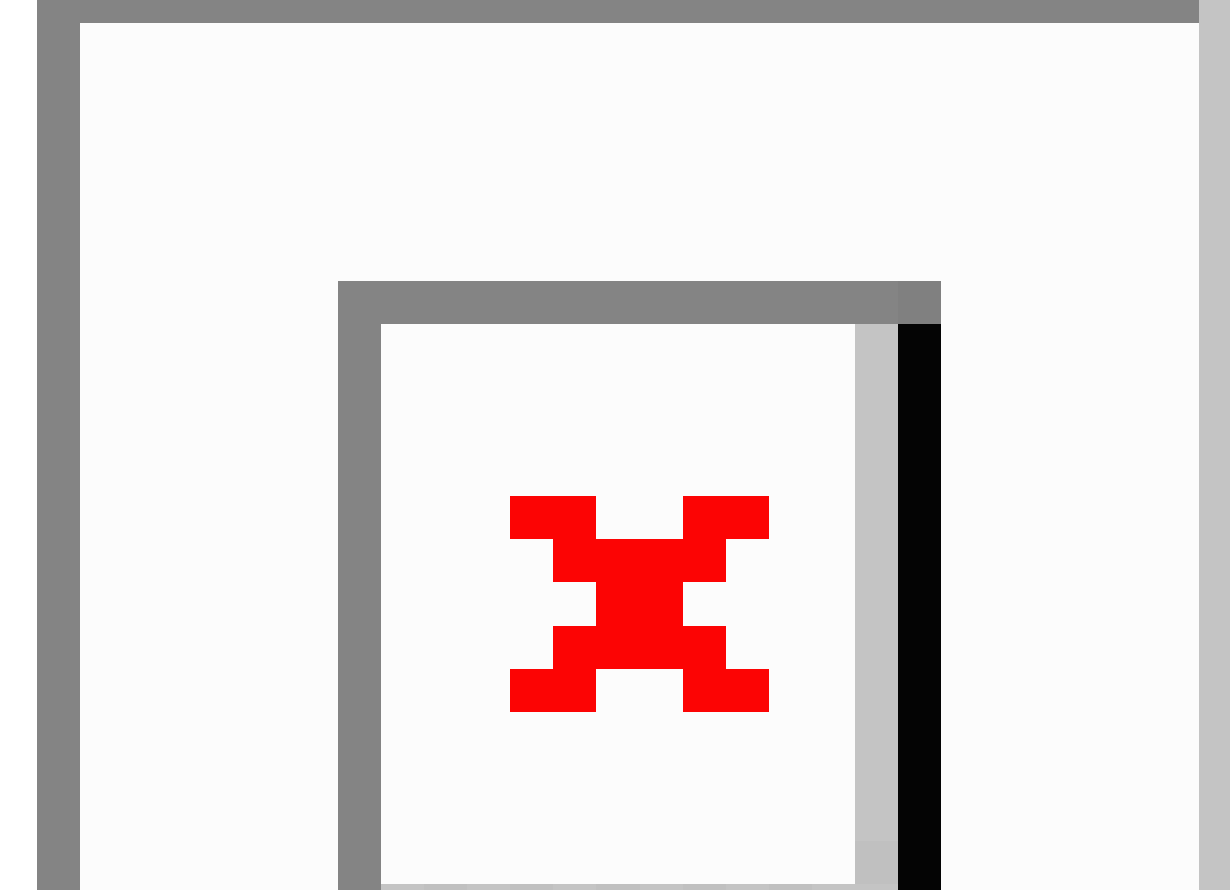
Figure 3. Summary of annotation results on sample of 170 messages. Tree structure indicates which codes are dependent on their parent codes. Different branches are not mutually